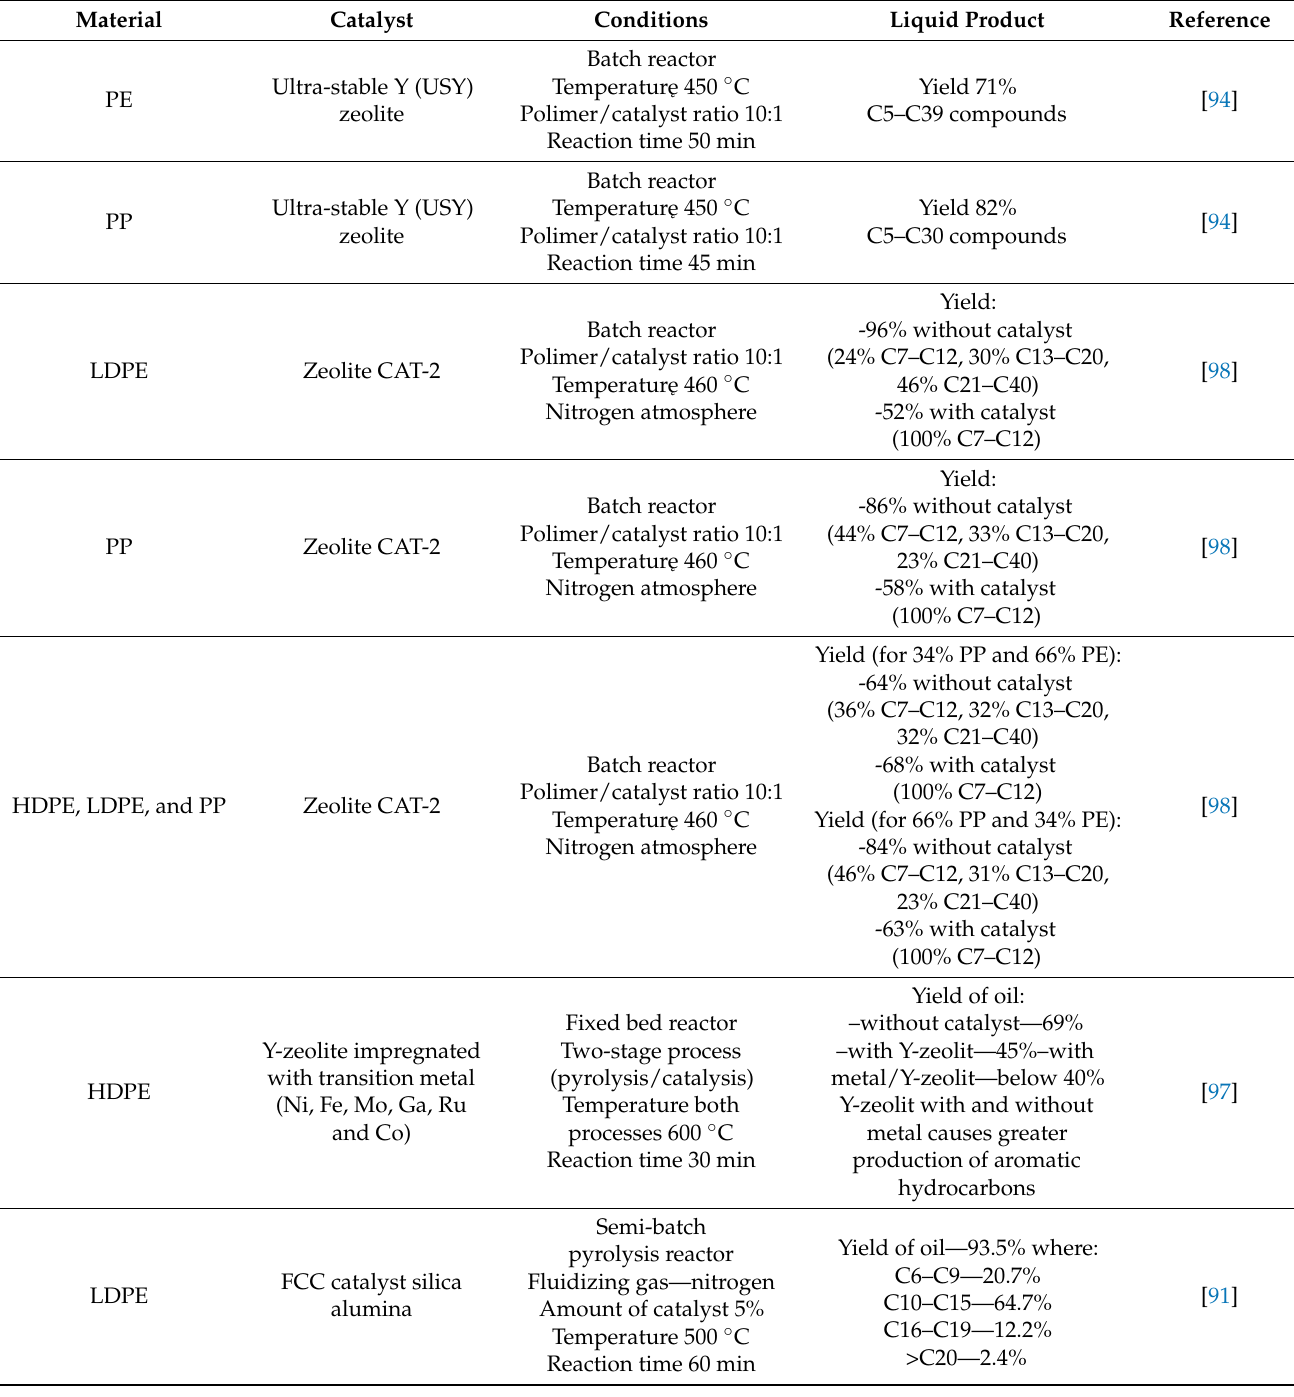
Table 3. Selected research works in the area of catalytic pyrolysis of plastic